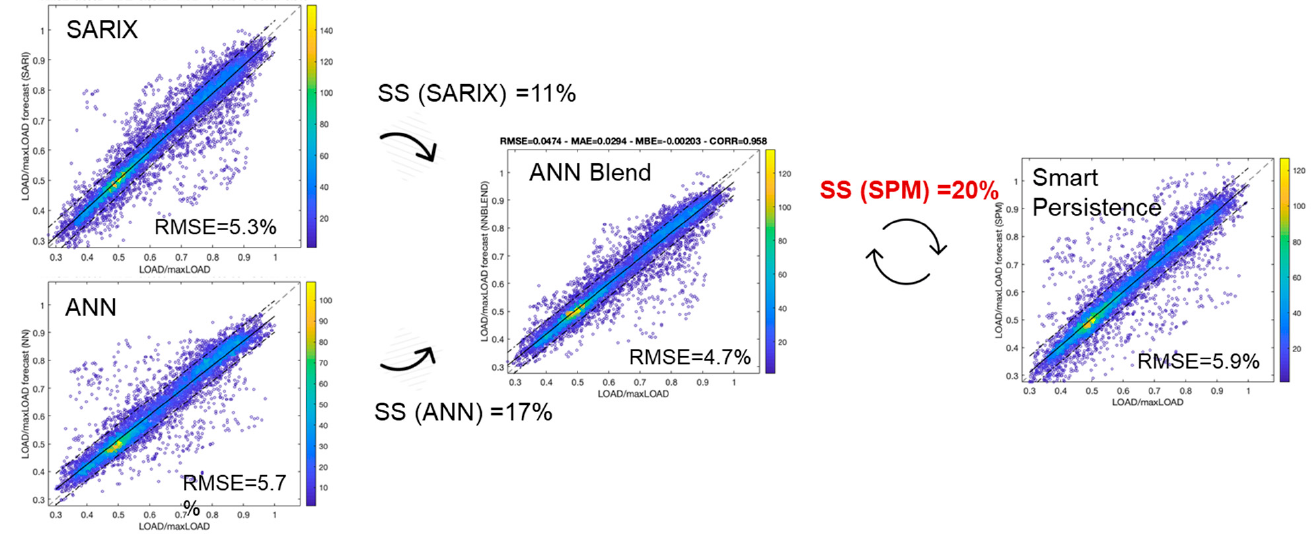
Figure 11. Scatterplots (forecast vs. observation) of the different forecasts used for the load prediction of the North zone (the zone with higher electric demand).